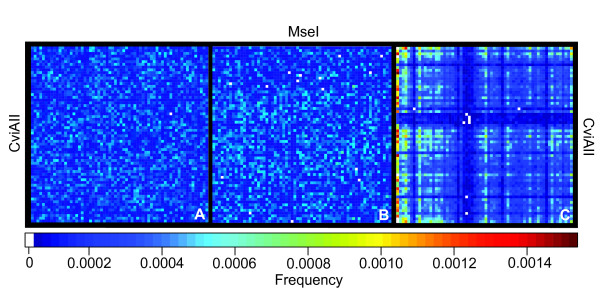
Empirical cDNA-AFLP data are highly structured. Patterning of cDNA-AFLP data. A and B: Patterning of complete arrays of selective PCR amplifications using CviAII and MseI restriction enzymes for (A) simulated random DNA, (B) simulated cDNA (following the standard eukaryotic codon table [25]), and (C) Homo sapiens cDNA. 10000 sequences of 1290 bp were simulated for both the DNA and cDNA datasets. Pixel intensity reflects the relative proportion of products obtained during selective in silico PCR. Pixels are ordered by selective base pairs: AAA (left, top) to TTT (bottom, right). White pixels indicate that no fragments were generated for this combination of selective base pairs.